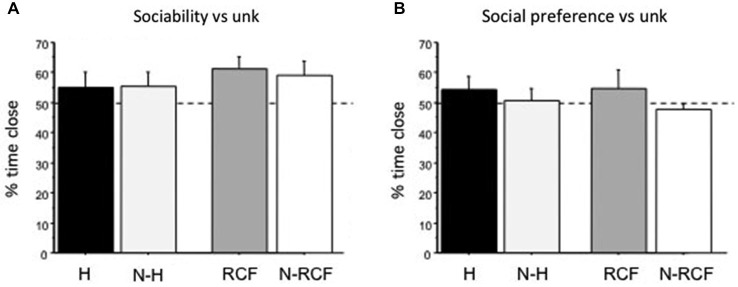
Sociability and Social Preference scores (mean + SE). (A) Sociability (preference for conspecific vs. object) and (B) Social preference (preference for conspecific vs. littermate) for unfamiliar male mouse (same strain, age and treatment) of juvenile males tested on PND28 and PND35, respectively. Both indices are calculated as the percentage of time spent close to unfamiliar partners (Time Close unfamiliar/(Total Time close to both cylinders) × 100). Sample sizes: 9–14 per group. Experimental groups: H: Handled; N-H: Non-Handled; RCF: Repeated Cross-Fostering; N-RCF: Control.